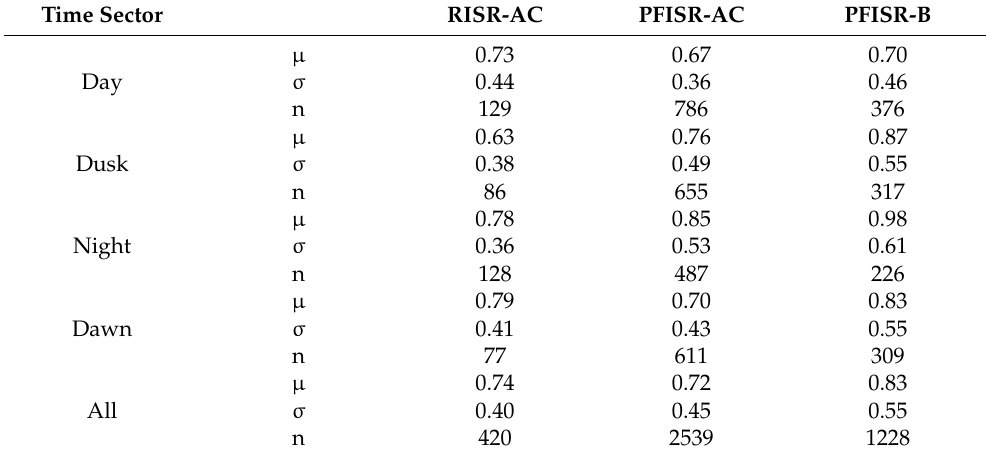
Table 1. The Median Value µ and the Standard Deviation σ for a Histogram Distribution of the Ratio R = N eSwarm /N eISR and Number of Points n or all Conjunctions between RISR-AC, PFISR-AC, and